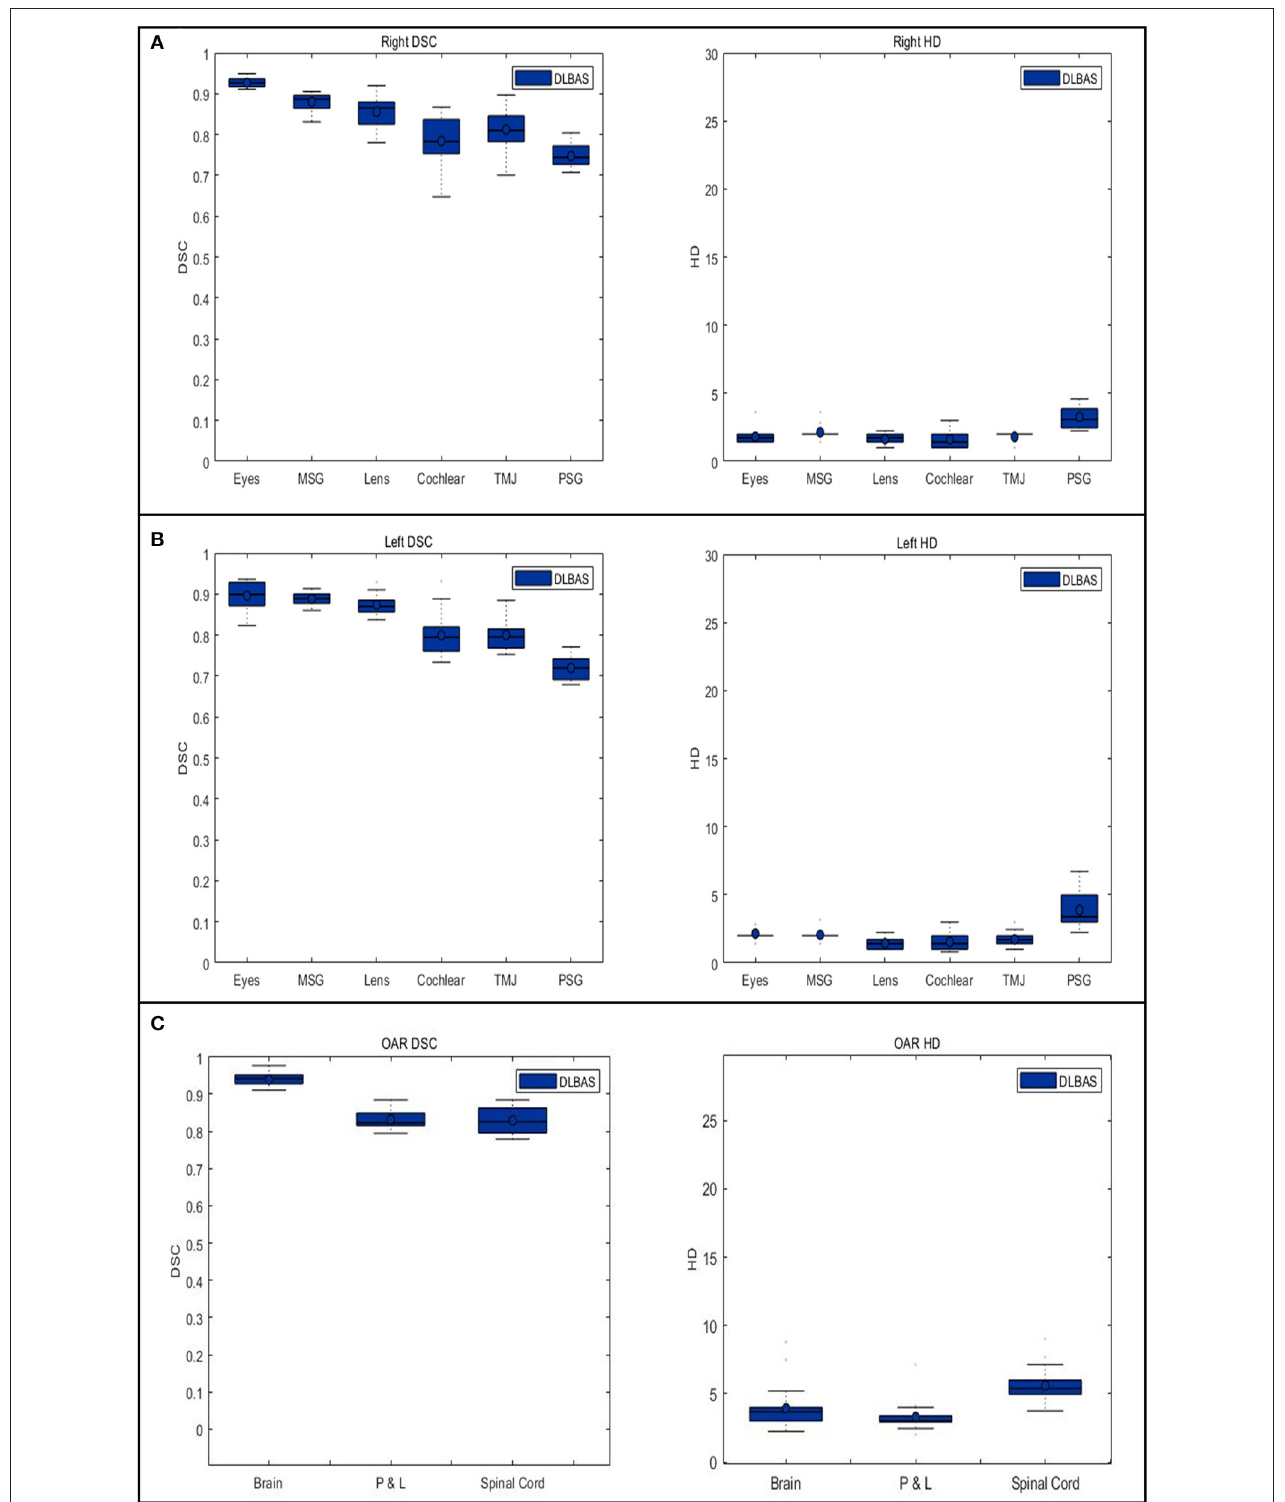
FIGURE 4 | Boxplots of the Dice similarity coefficient and Hausdorff distance in each organ at risk are obtained from deep-learning-based automatic segmentation. (A) right organs, (B) left organs, and (C) other OARs. DSC, Dice similarity coefficient; HD, Hausdorff distance; OAR, organ at risk; MSG, mandibular salivary gland; TMJ, temporomandibular joint; PSG, parotid salivary gland; P & L, pharynx, and larynx.